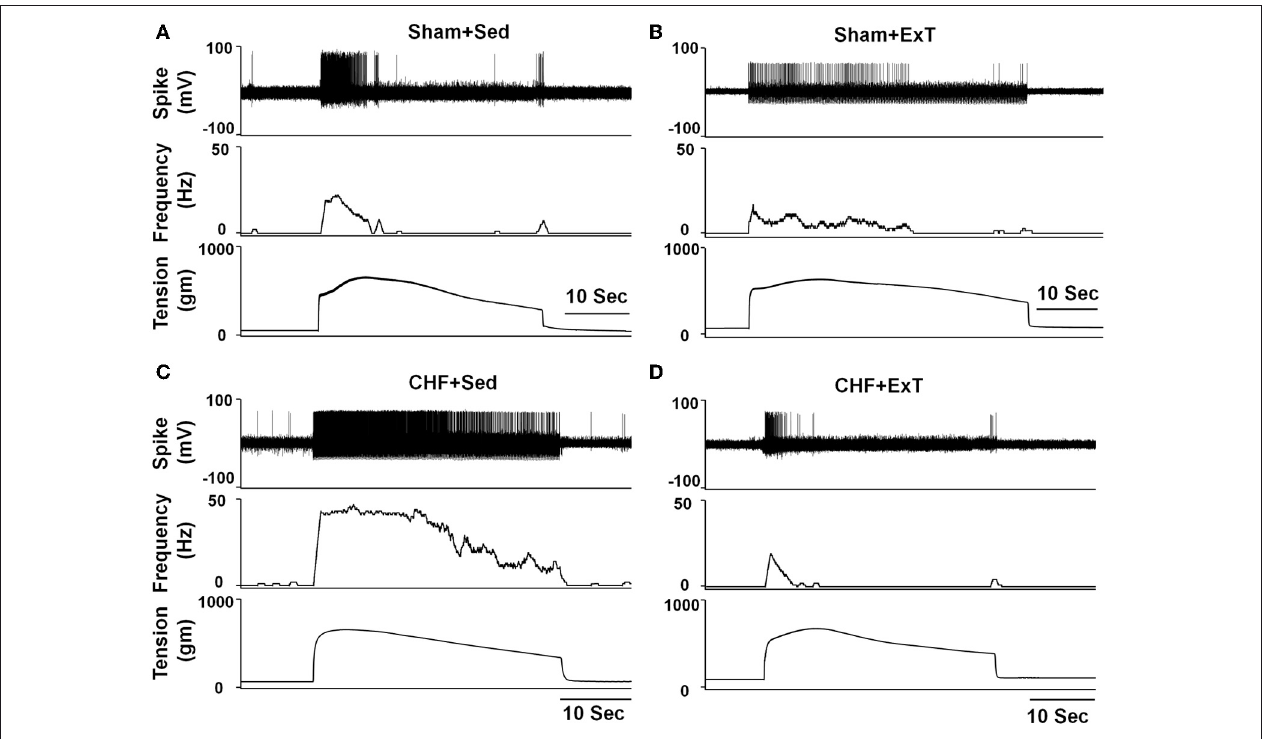
Sham + ExT(CV, 3.0m/s, B), CHF + Sed (CV, 4.7m/s, C) and CHF + ExT rats (CV, 5.3m/s, D). [Reprinted from Wang et al. (2012). Copyright @ 2012 American Heart Association. Used with